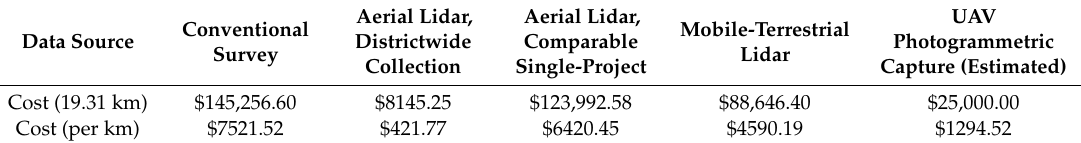
Table 6. Cost comparison of each data source